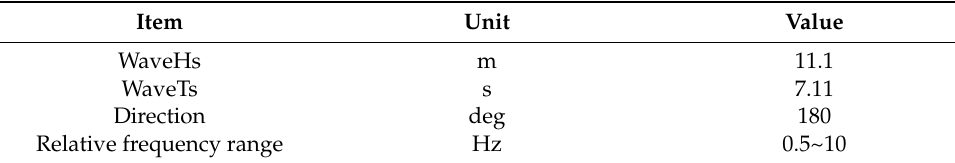
Table 7. Parameters of Jonswap spectrum in storm self-survival condition. Item Unit